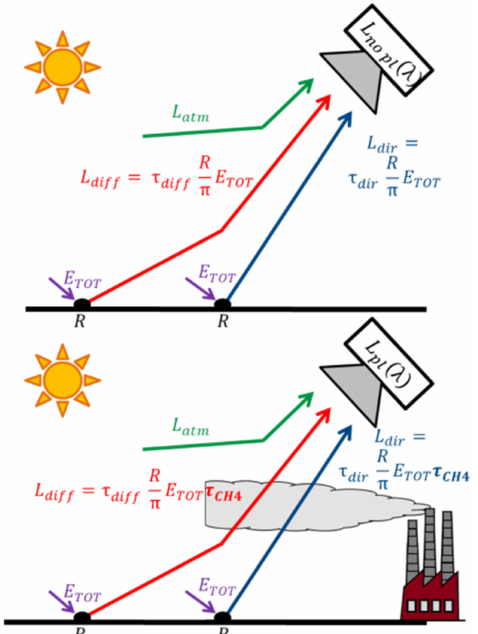
Figure A1. Scheme of the radiances according to the direct model. The term E TOT describes the total solar irradiance received at the target pixel. It takes into account the direct and diffusive irradiances and the irradiance resulting from the ground–atmospheric coupling and can be written as E TOT = E 0 / ( 1 − RS )